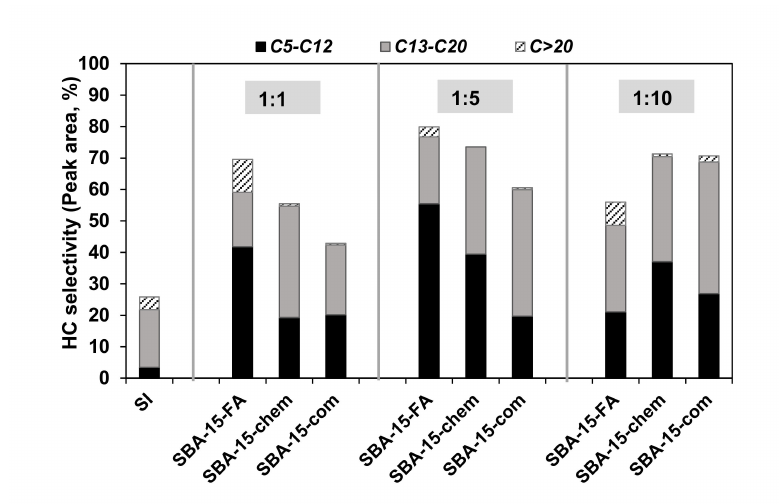
Figure 12. Hydrocarbon selectivity of the pyrolytic products from the SI residues with SBA-15 catalysts.